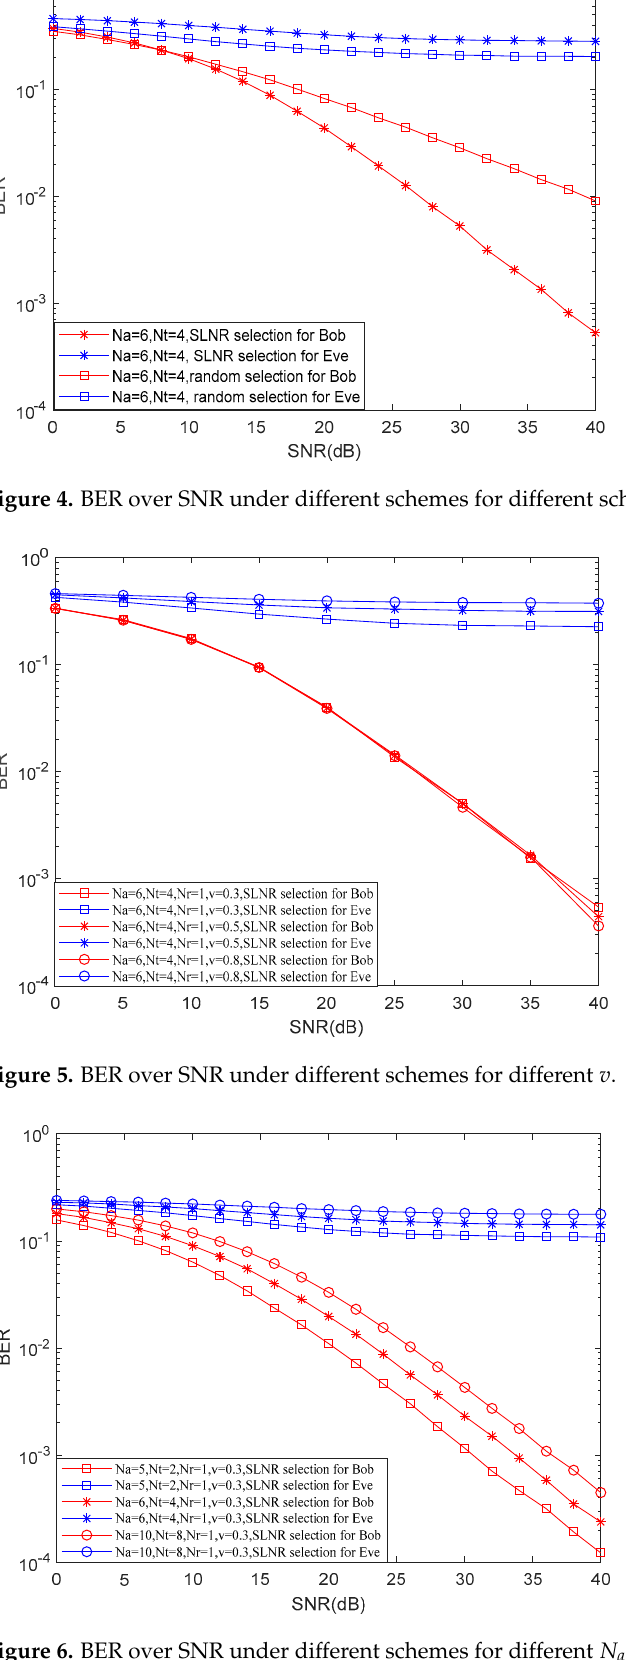
Figure 6. BER over SNR under different schemes for different N a and N t